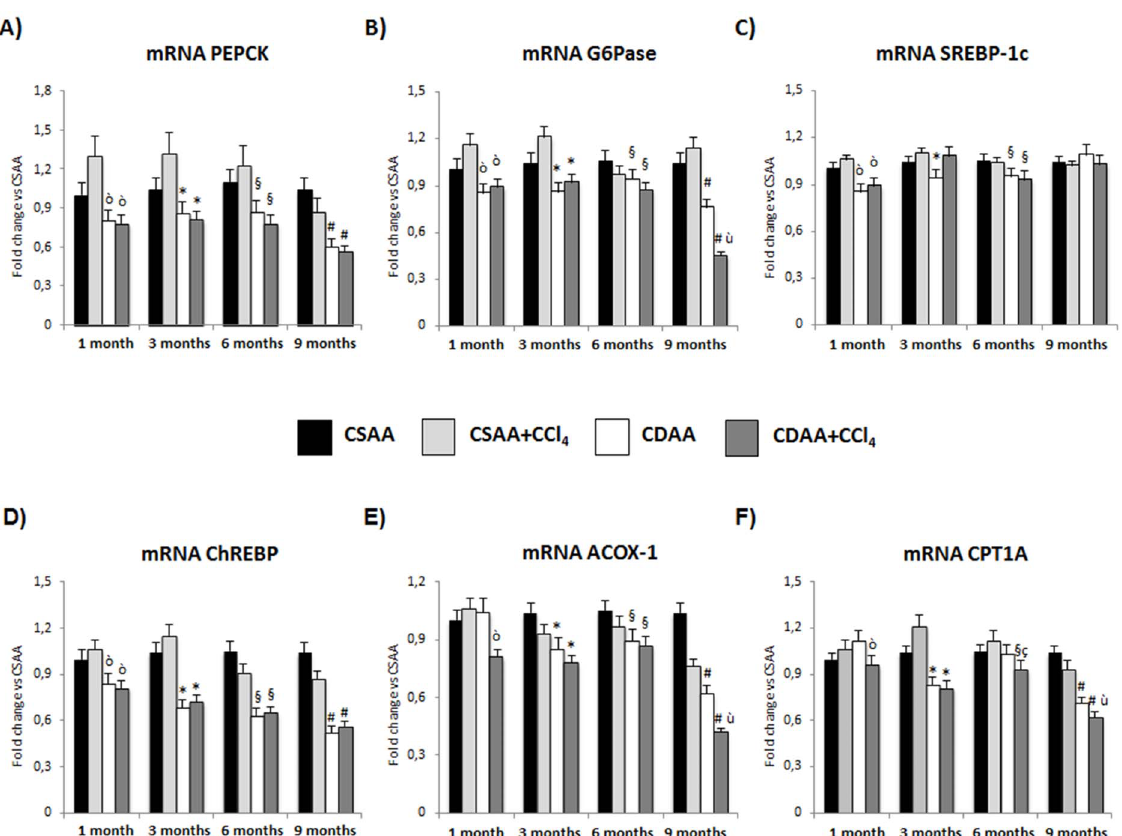
Figure 3. Gene expression of elements involved in carbohydrate and lipid metabolism. qRT-PCR expression shows a progressive decrease of the amount of PEPCK (A), G6Pase (B), ChREBP (D), ACOX-1 (E) and CPT1A (F) mRNA expression in the groups of CDAA or CDAA + CCl 4 , while only a slight decrease is observed for mRNA expression of SREBP-1c (C). Data represent mean 6 SD; o` p , 0.05 vs CSAA 1 month; *p , 0.05 vs CSAA 3 months; 1 p , 0.05 vs CSAA 6 months; # p , 0.05 vs CSAA 9 months; c¸ p , 0.05 vs CDAA 6 months; u` p , 0.05 vs CDAA 9 months.